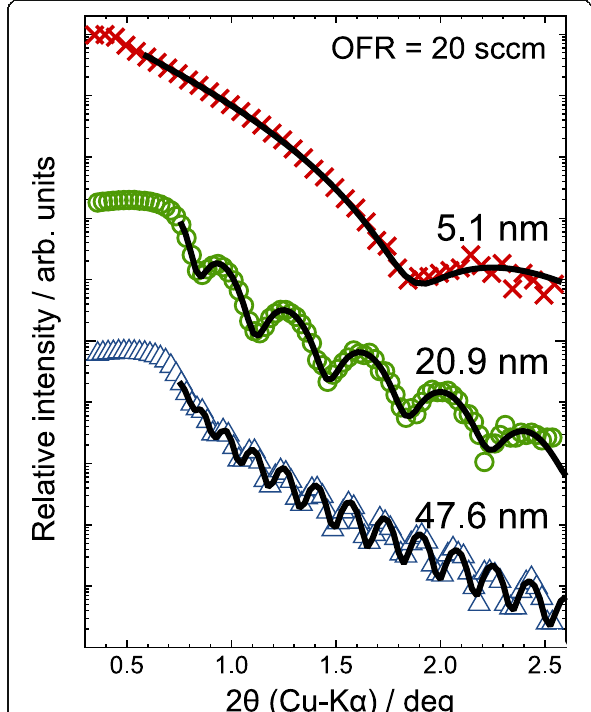
Fig. 2 XRR data (crosses, circles, and triangles) and fitted curves (solid lines) of a -ITO films with thicknesses of 5.1, 20.9, and 47.6 nm grown at an OFR of 20 sccm